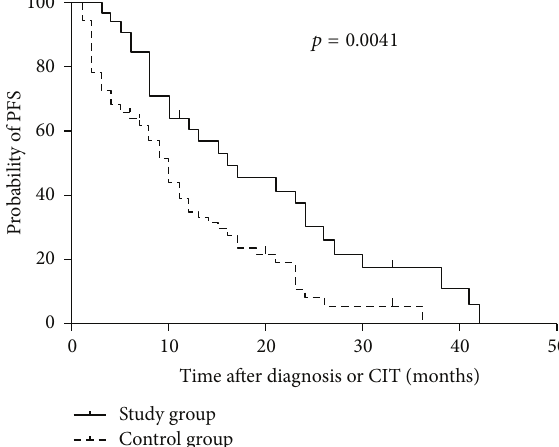
Figure 3: Progression-free survival (PFS) in study and control group. The median PFS in study ( 𝑛 = 31 ) and control group ( 𝑛 = 73 ) was 16 and 10 months, respectively ( 𝑝 = 0.0041